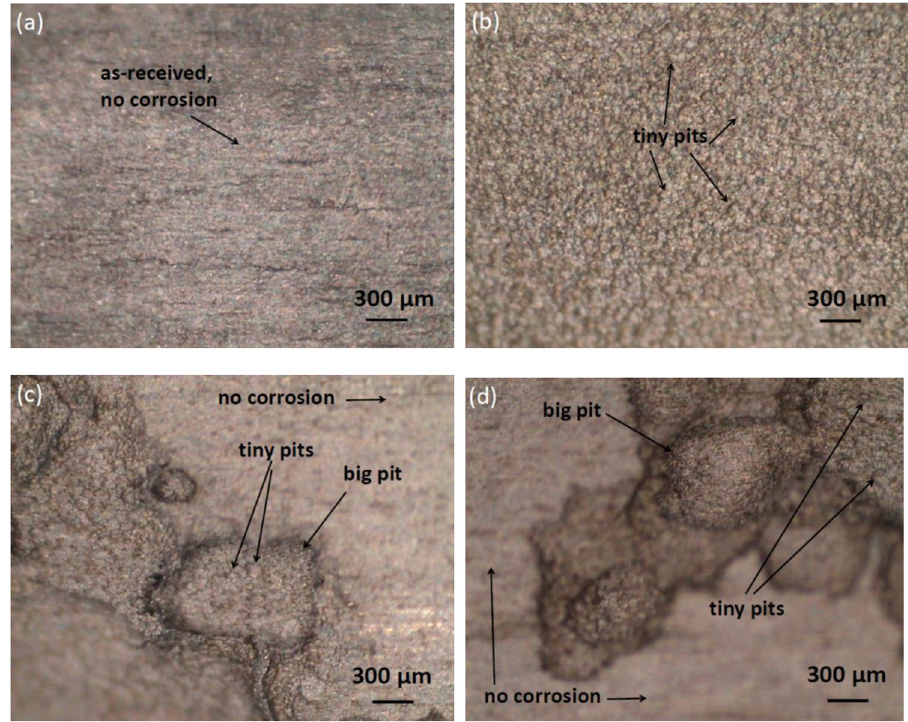
Figure 12: The light micrograph ( 60 ×) of the surface morphology of steel wire – ( a ) as - received, ( b ) pits at 1 M Cl − and − 200 mV, ( c ) pits at 1 M Cl − and − 350 mV, and ( d ) pits at 0.5 M Cl − and − 200